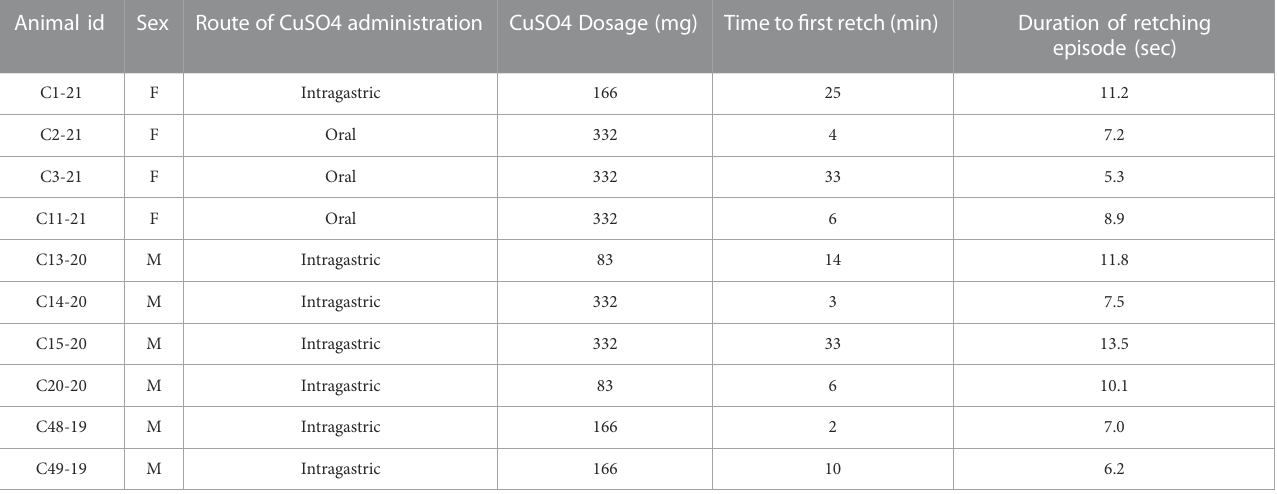
TABLE 2 Responses of animals to CuSO4